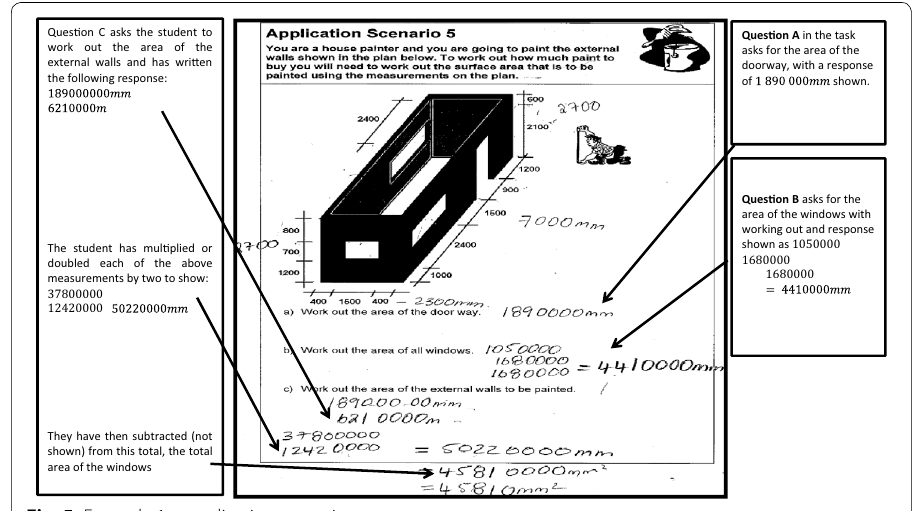
Fig. 5 Example 1—application